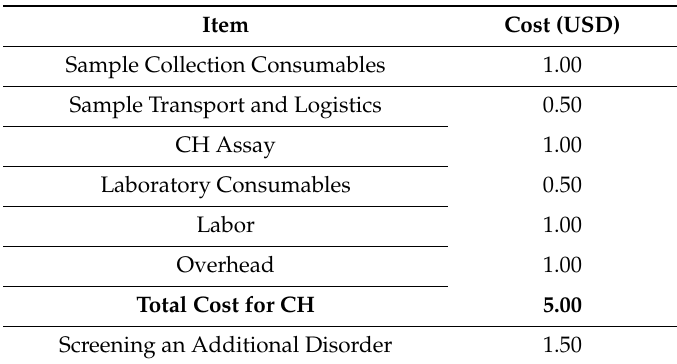
Table 1. Costs for performing a congenital hypothyroidism (CH)